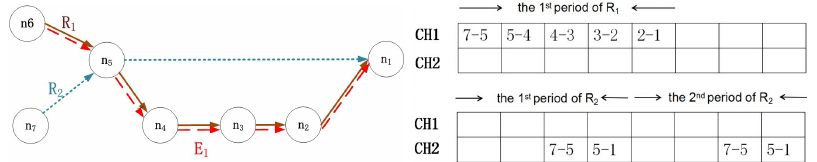
Figure 3. An example of stealing-first scheduling algorithm